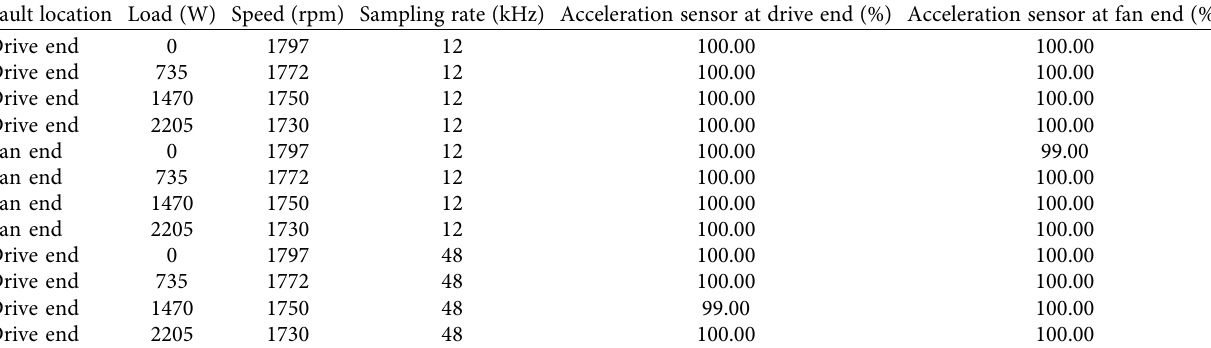
Table 12: Accuracy results of bearing database of western reserve university under different working conditions.